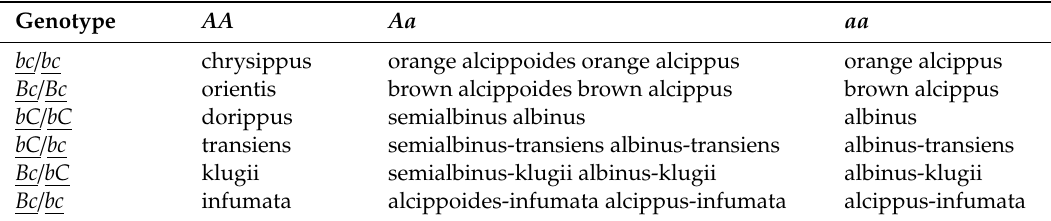
Table 2. Nomenclature and genotypes of the colour forms of D. chrysippus